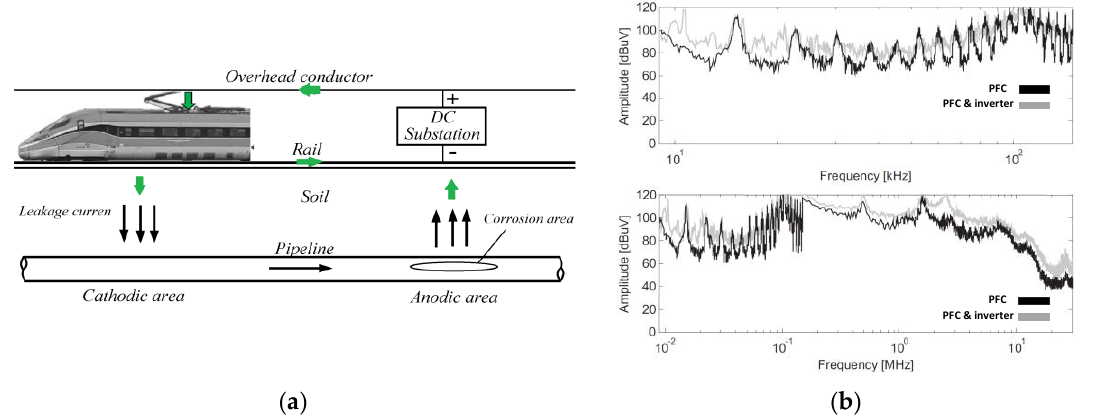
Figure 22. Different forms of conducted EMI (CEMI) in ERPS. ( a ) Simple diagram of stray current phenomena in DC ERPS. ( b ) Output measured EMI in 4QC without filter (output frequency = 15 Hz) [137].